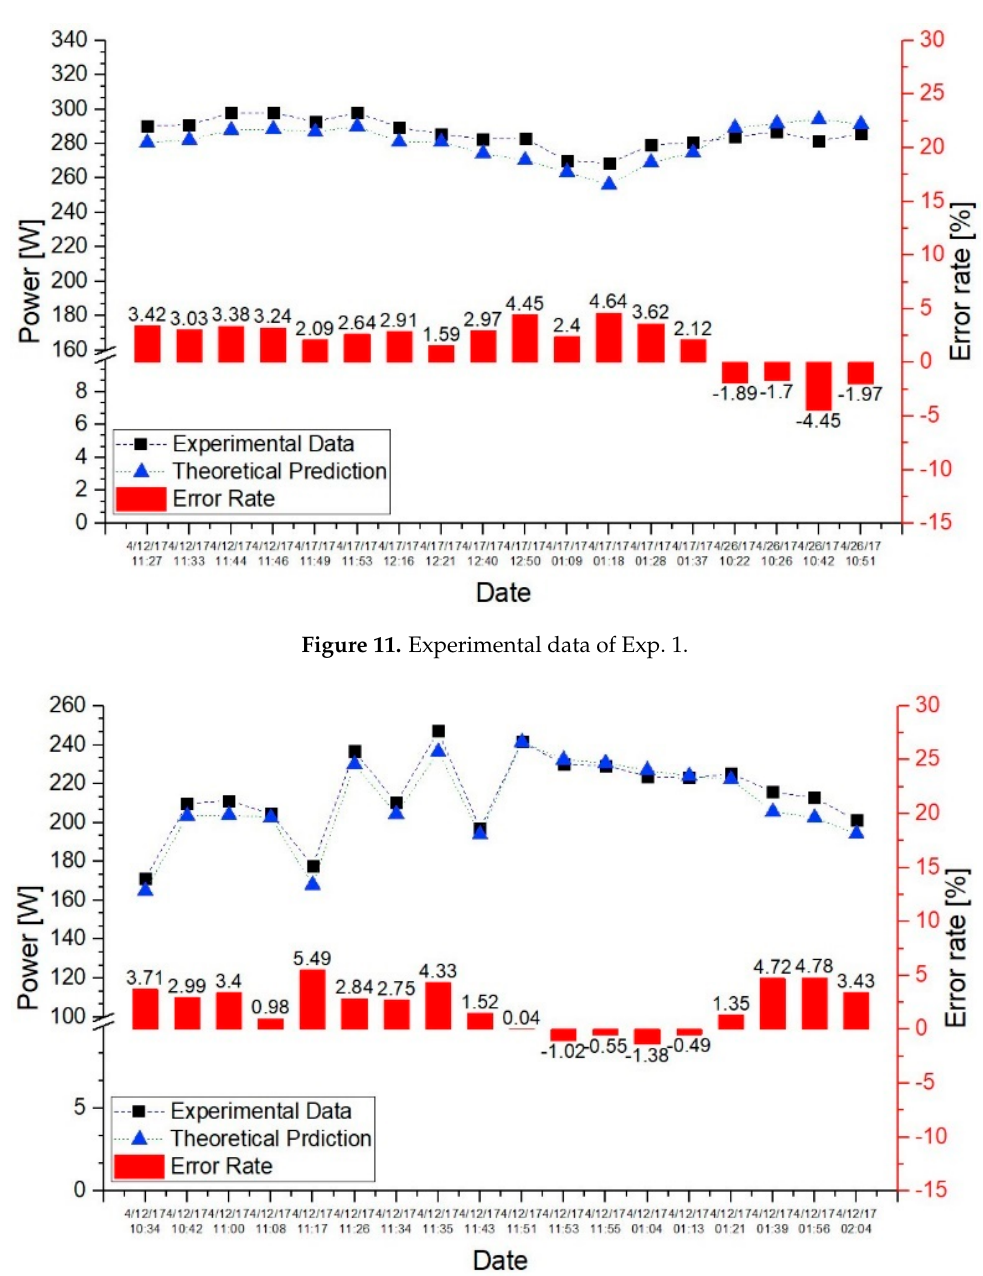
Figure 10. I–V test results.